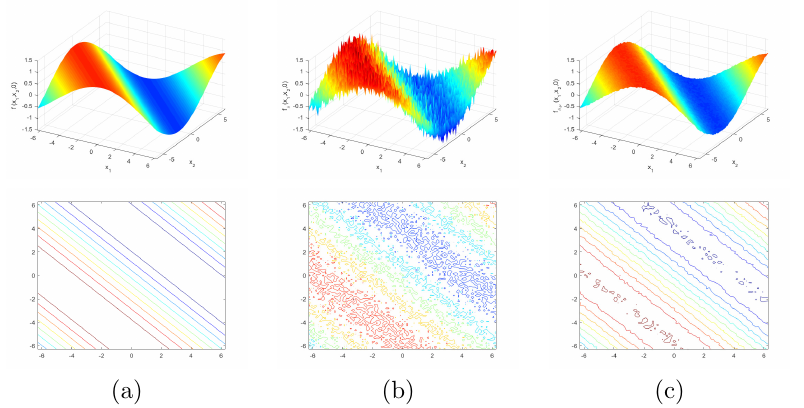
Figure 7. Sources for Example 5: original (a), unregularized (b) and regularized (c) for z = 0 assuming α 2 = 0 . 4 , β = (1 , − 0 . 5 , − 0 . 5) ,ν = 0 . 997 ,t 0 = 3 ,p = 3 and (cid:15) = 0 .